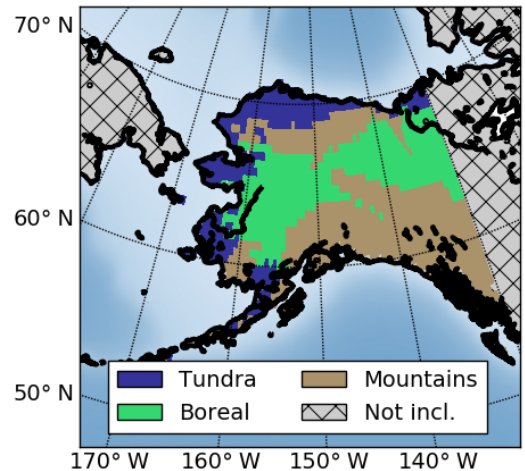
Figure 1. Eco-regions derived from the Commission for Environ- mental Cooperation Level II Terrestrial Eco-regions. The study re- gion is defined by the coastline and filled